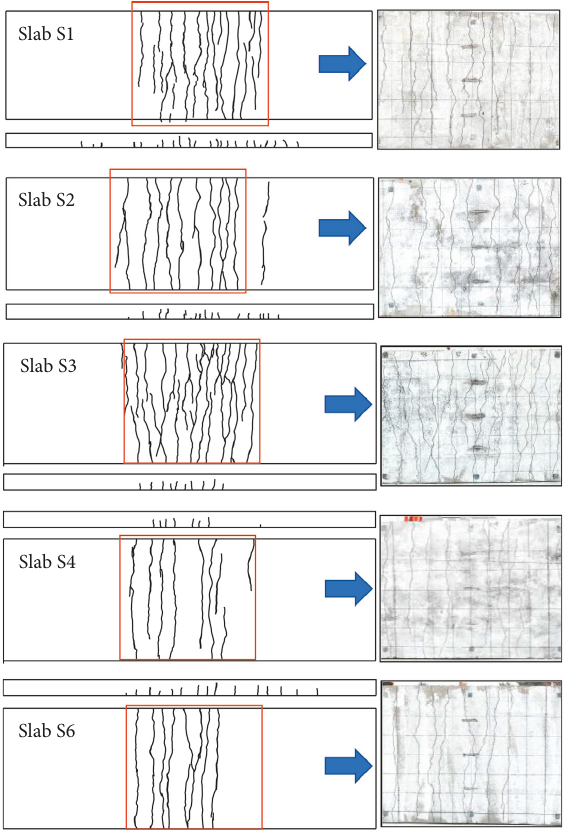
Figure 7: Images of the cracks. Table 3: Crack distribution and damage characteristics.